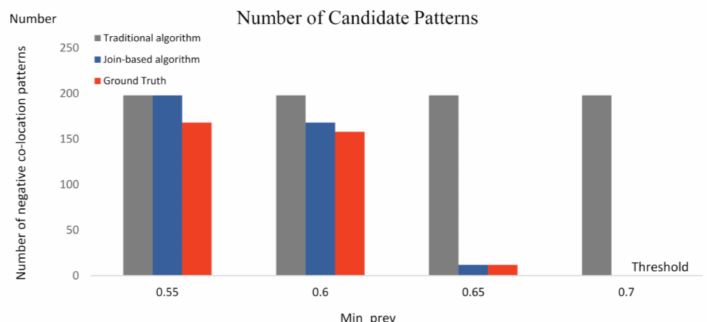
Figure 15. The traditional algorithm and the J-B negative C-L algorithm need to calculate the comparison between the number of PT and the actual negative C-LP.